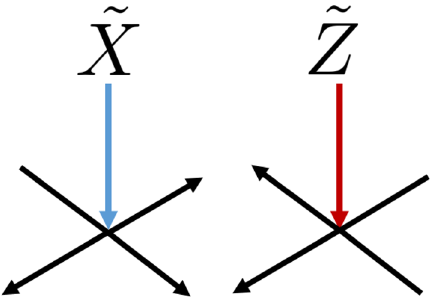
˜ Figure 14. Logical X pushes to any 3 legs while logical imply the operator is weight 3 N or 2 N , because some are identity operators even though they act non-trivially on a tensor leg. For example, in the double-copy, logical ˜ X has weight 4 while logical ˜ Z is weight